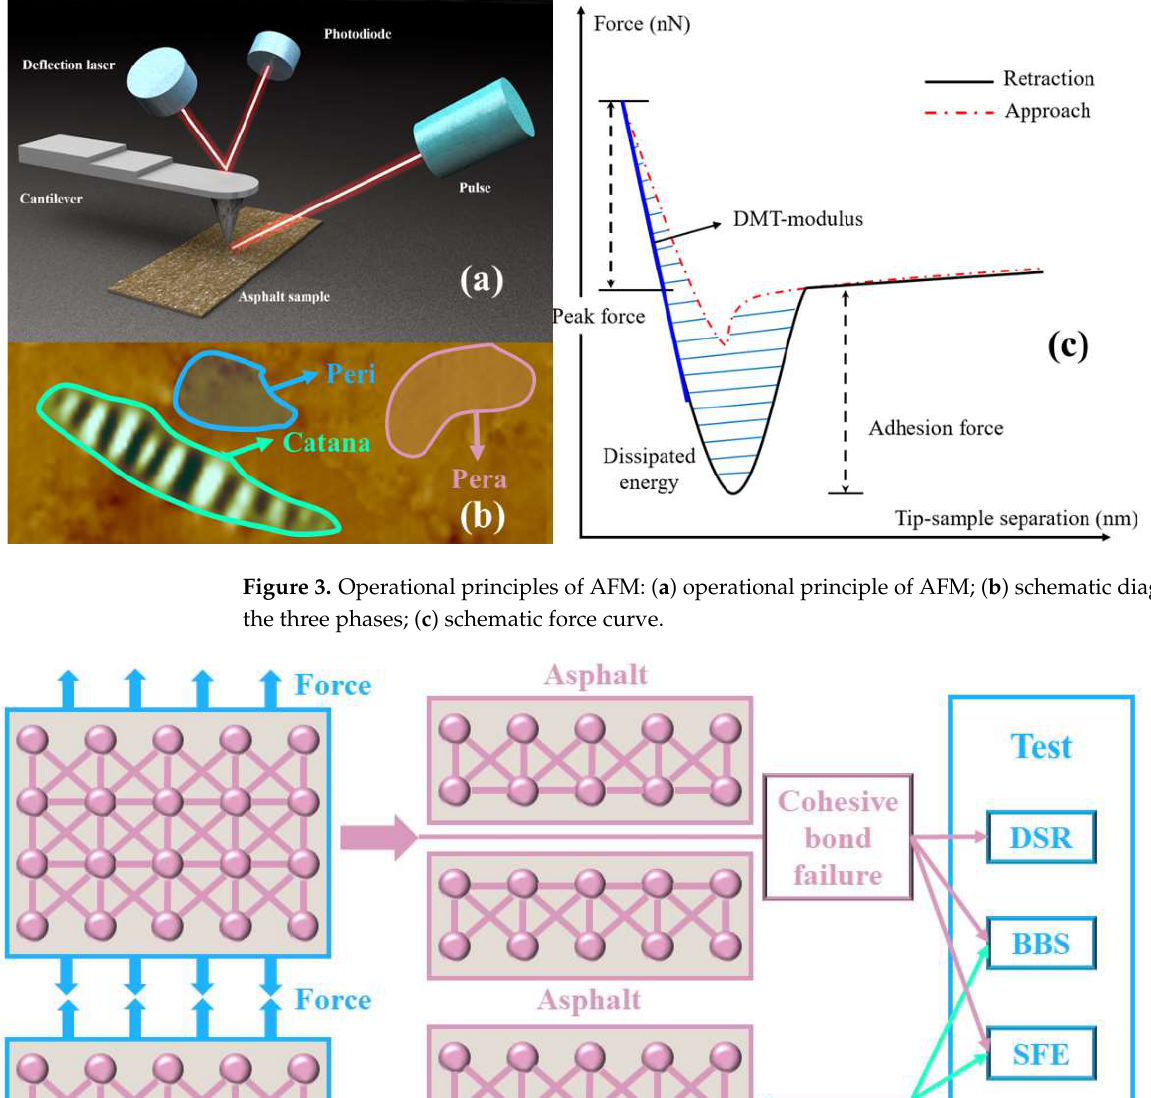
Figure 3. Operational principles of AFM: ( a ) operational principle of AFM; ( b ) schematic diagram of the three phases; ( c ) schematic force curve.